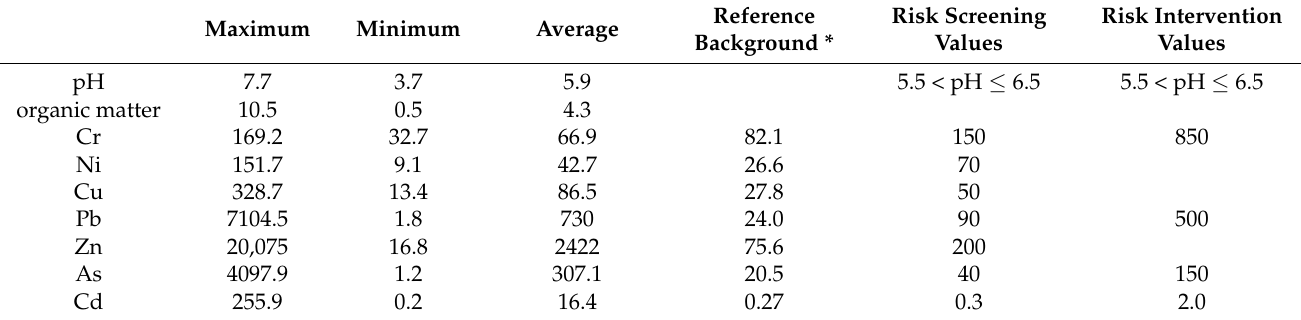
Table 3. Statistical parameters of pH value, organic matter, and heavy metal content of the farmland soil around Dachang mining